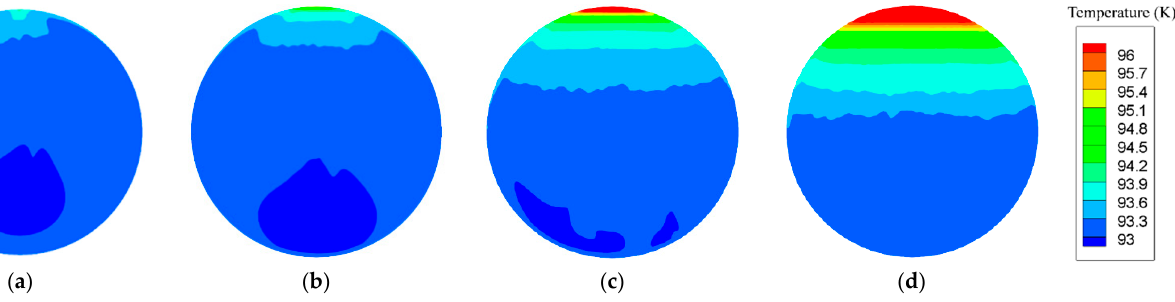
Figure 9. Temperature distribution during the static evaporation. ( a ) t = 20 s; ( b ) t = 40 s; ( c ) t = 120 s; ( d ) t = 300 s.